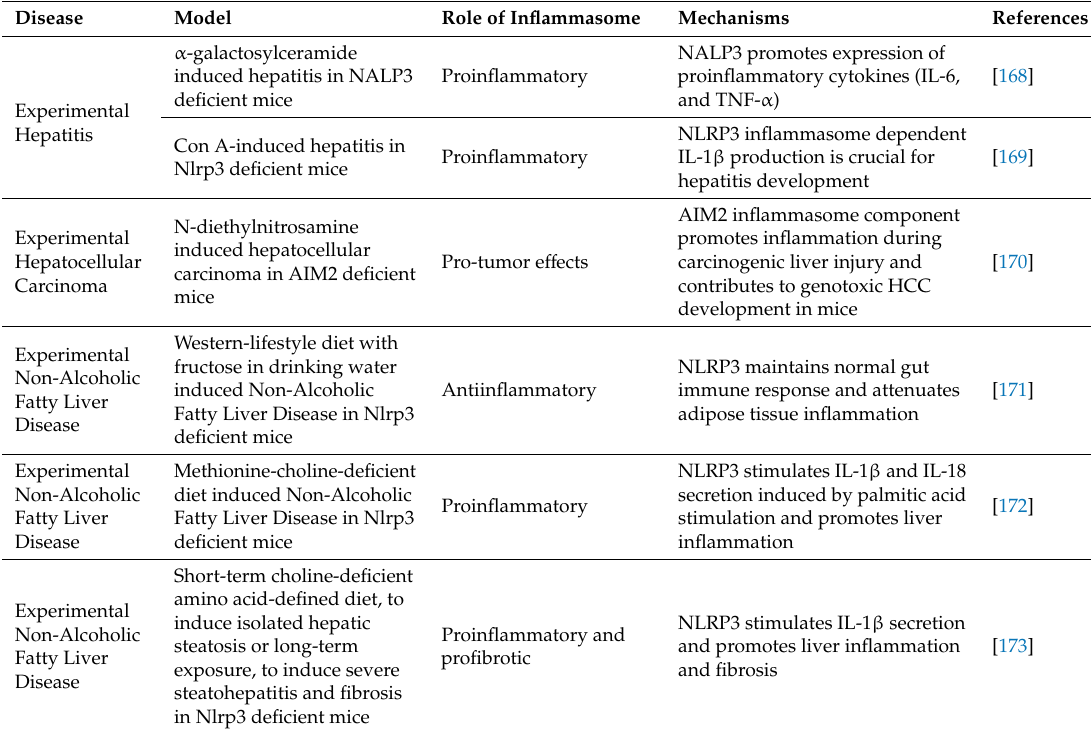
Table 2. Immunoregulatory role of inflammasome in inflammatory and malignant liver diseases.